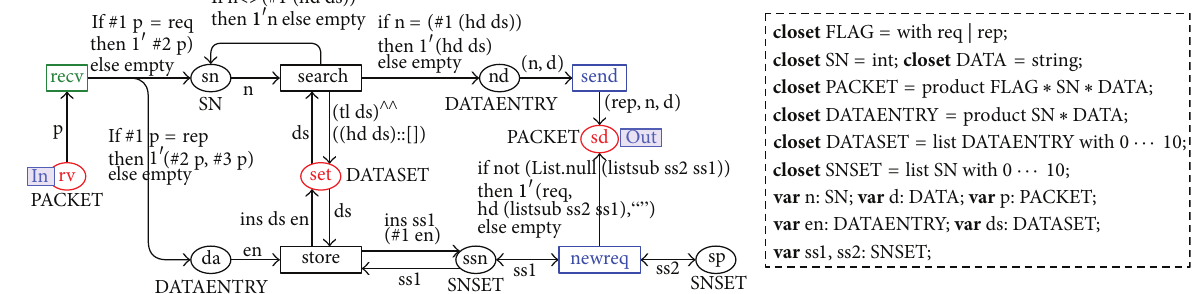
Figure 2: The CT-CPN 𝑆 model of the file sharing software system.